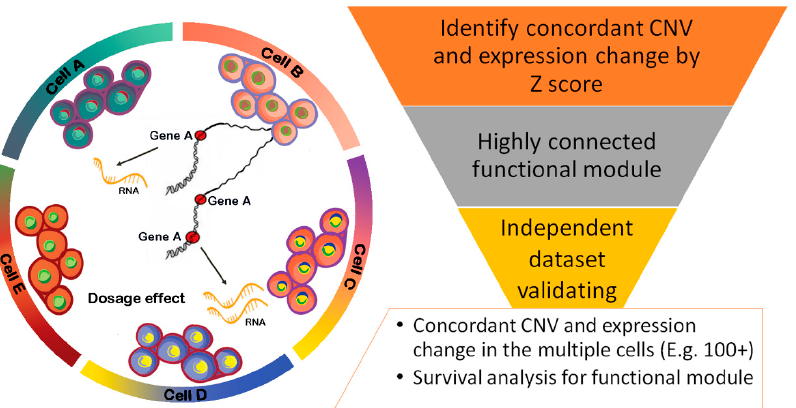
Figure 1. The workflow to explore the global CNV patterns across multiple cell types with gene expression changes at the single-cell level. This workflow starts from the CNV and expression profiling at the single-cell level from the same tissue samples. By mapping the CNV and gene expression changes in the same cells, this workflow will identify concordant CNV and expression changes. By running the gene–gene interaction network analysis, the workflow will build highly connected functional modules to prioritize the key genes with significant gene dosage effects. We also recommend validating the whole process by integrating other independent datasets with both CNV and expression data at the single-cell level. The final validated functional modules in multiple cells will be highly reliable for further clinical feature evaluation and experimental validation.